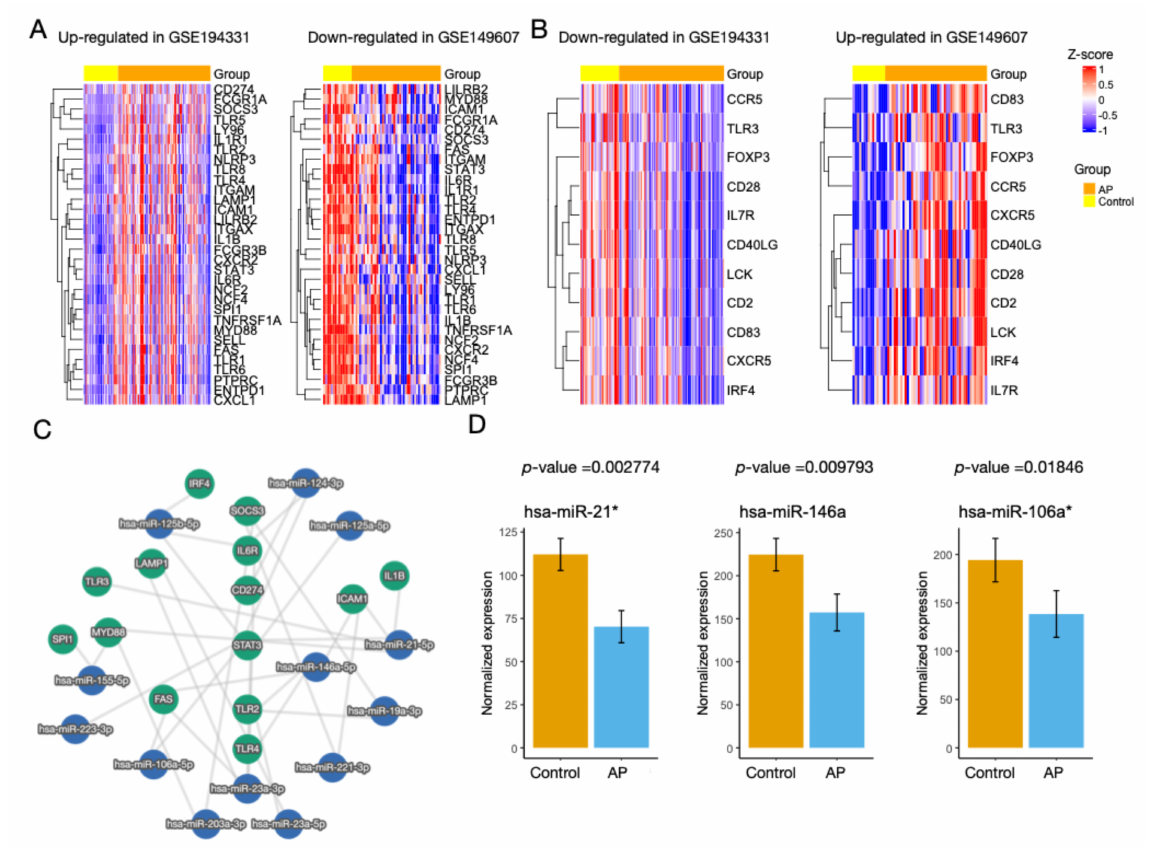
Figure 3. Regulation of hub genes in CS- and non-CS-associated AP. ( A , B ) Heatmaps show hierar- chical clustering of hub gene expression in GSE194331 and GSE149607. Conditions of up-regulation and down-regulation are separated. Expression levels are normalized to the z-score. Columns of heatmaps are divided into AP and control. ( C ) Interaction graph of selected hub genes and miRNAs derived from miRTargetLink 2.0. A central component of hub genes with high node degrees is shown. ( D ) Box plots show expression of hsa-miR-21*, hsa-miR-146a, and hsa-miR-106a* between AP and control in GSE31568. Wilcoxon’s rank sum test P values are shown. * indicates the product is from the opposite arm of the miRNA